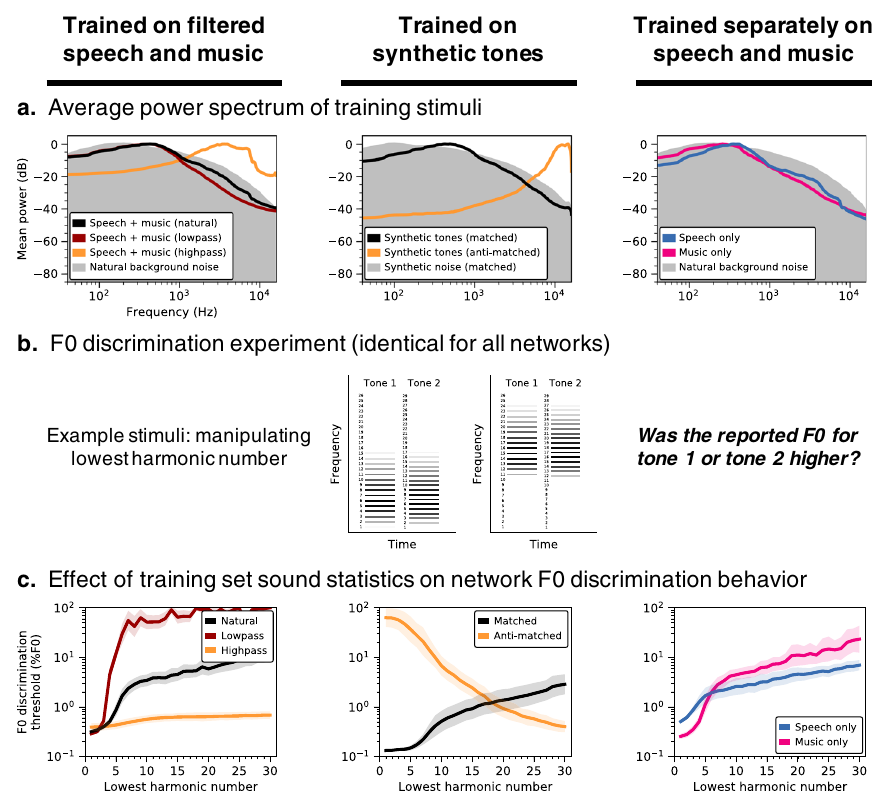
Fig. 7 Pitch perception depends on training set sound statistics. a Average power spectrum of training stimuli under different training conditions. Networks were trained on datasets with lowpass- and highpass- fi ltered versions of the primary speech and music stimuli (column 1), as well as datasets of synthetic tones with spectral statistics either matched or anti-matched (Methods) to those of the primary dataset (column 2), and datasets containing exclusively speech or music (column 3). Filtering indicated in column 1 was applied to the speech and music stimuli prior to their superposition on background noise. Gray shaded regions plot the average power spectrum of the background noise that pitch-evoking sounds were embedded in for training purposes. b Schematic of stimuli used to measure F0 discrimination thresholds as a function of lowest harmonic number. Two example trials are shown, with two different lowest harmonic numbers. c F0 discrimination thresholds as a function of lowest harmonic number, measured from networks trained on each dataset shown in A. Lines plot means across the ten networks; error bars indicate 95% con fi dence intervals bootstrapped across the ten